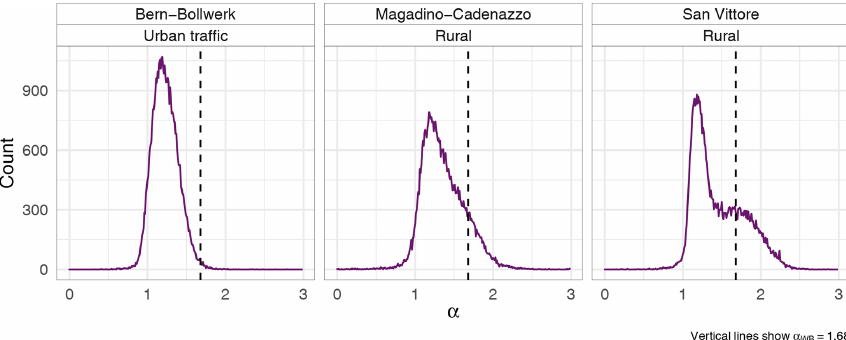
Figure 4. Counts of binned Ångström exponents ( α ) for three equivalent black carbon (EBC) monitoring sites’ hourly absorption observations in Switzerland between 2014 and 2018. The α value has been calculated from seven wavelengths between 370 and